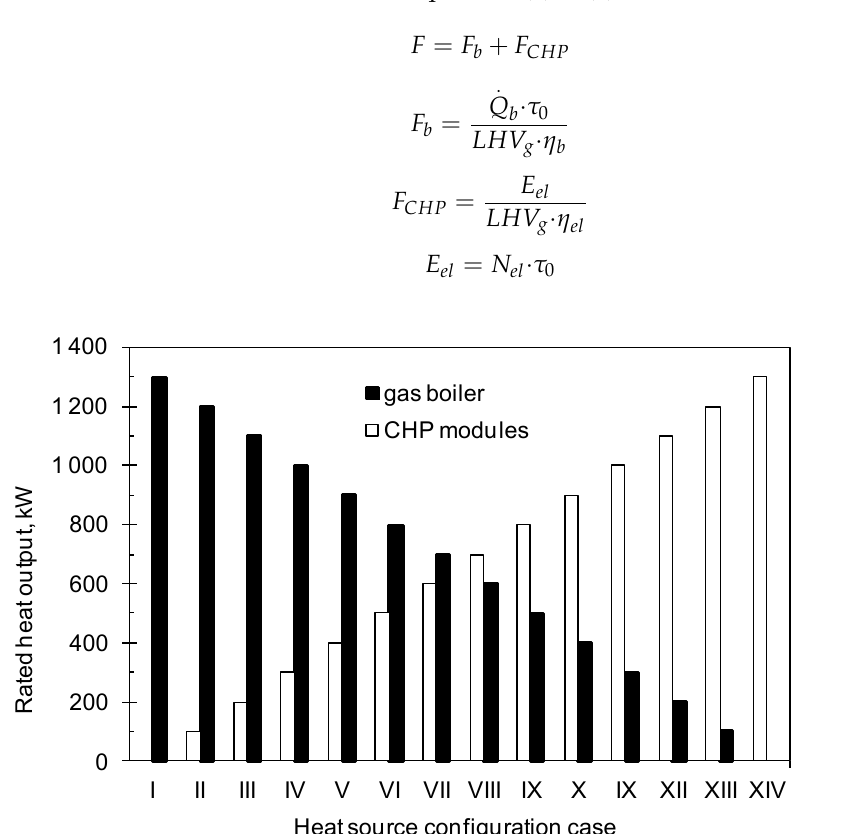
Figure 4. The CHP size cases created for the optimization process.